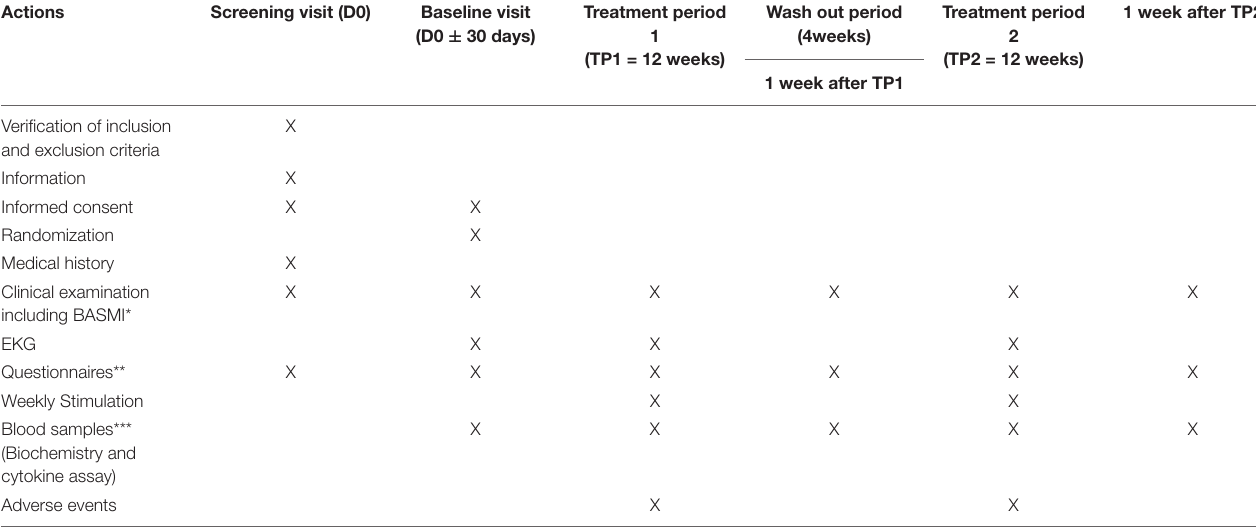
TABLE 1 | Organization of the ESNV-SPA